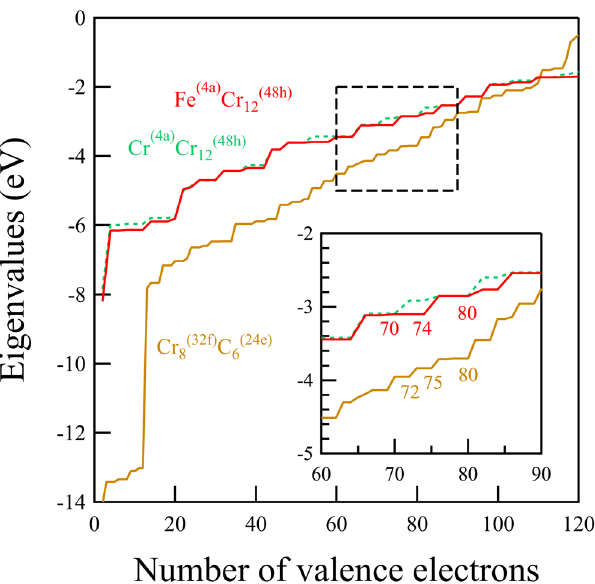
Figure 3. Computed eigenvalues for isolated neutral Cr 8(32f) C 6(24e) , Cr (4a) Cr 12(48h) and Fe (4a) Cr 12(48h)